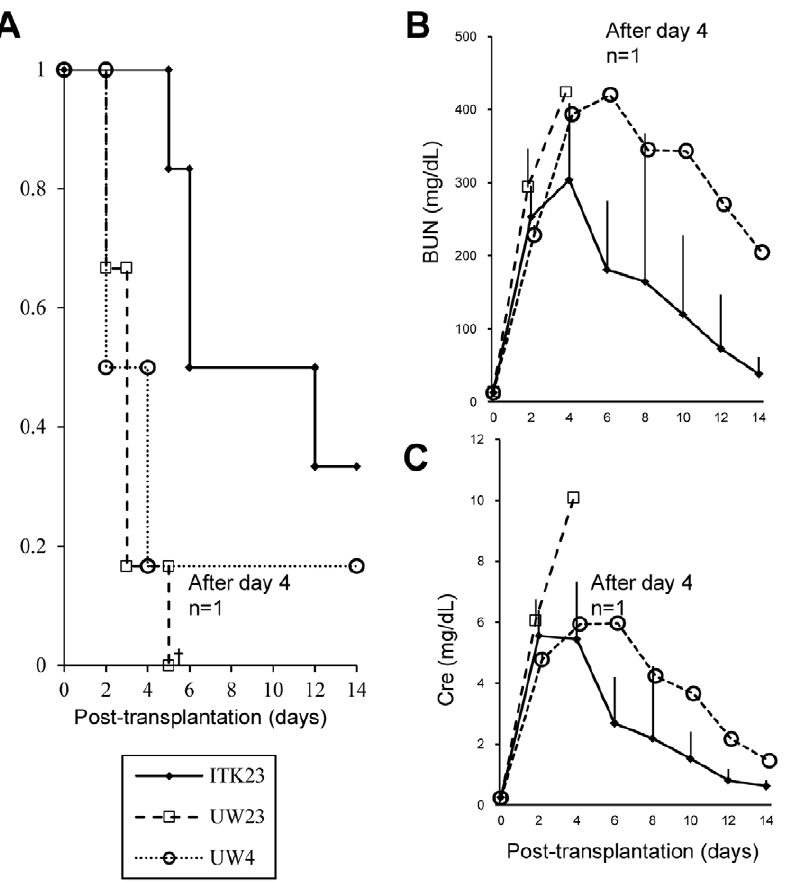
Figure 3. Survival rate, blood urea nitrogen (BUN) and serum creatinine (Cre) levels in experiment 3. (A): Preservation with ITK at 23 u C (ITK23) tended to increase the survival rate compared to UW at 4 u C ( p =0.09) and UW at 23 u C ( p , 0.01). (B): BUN and Cre levels of all surviving rats were gradually recovered to a normal range by day 14 after RTx. (BUN and Cre levels of the UW4 group were based on a single animal after day 4.)